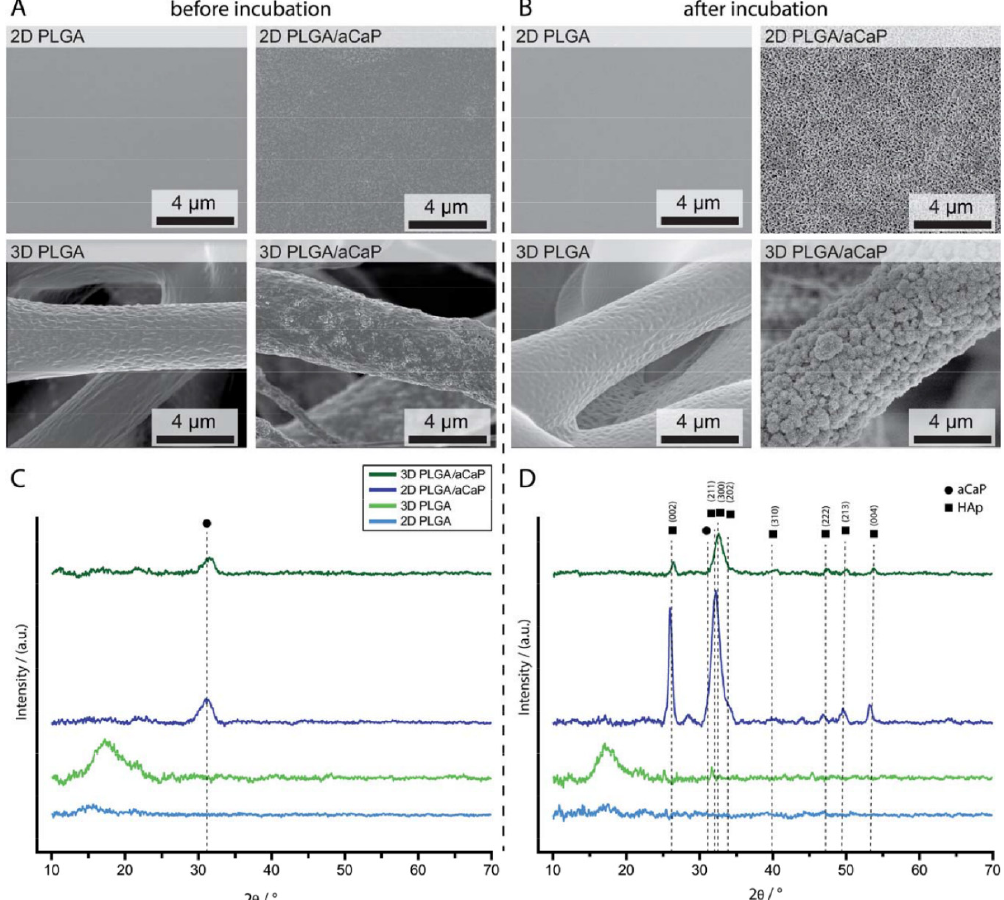
Figure 1. SEM images of the surface of poly(lactic-co-glycolic acid) (PLGA) and amorphous calcium phosphate nanoparticles (PLGA/aCaP) fabricated as films or electrospun meshes ( A ). On the